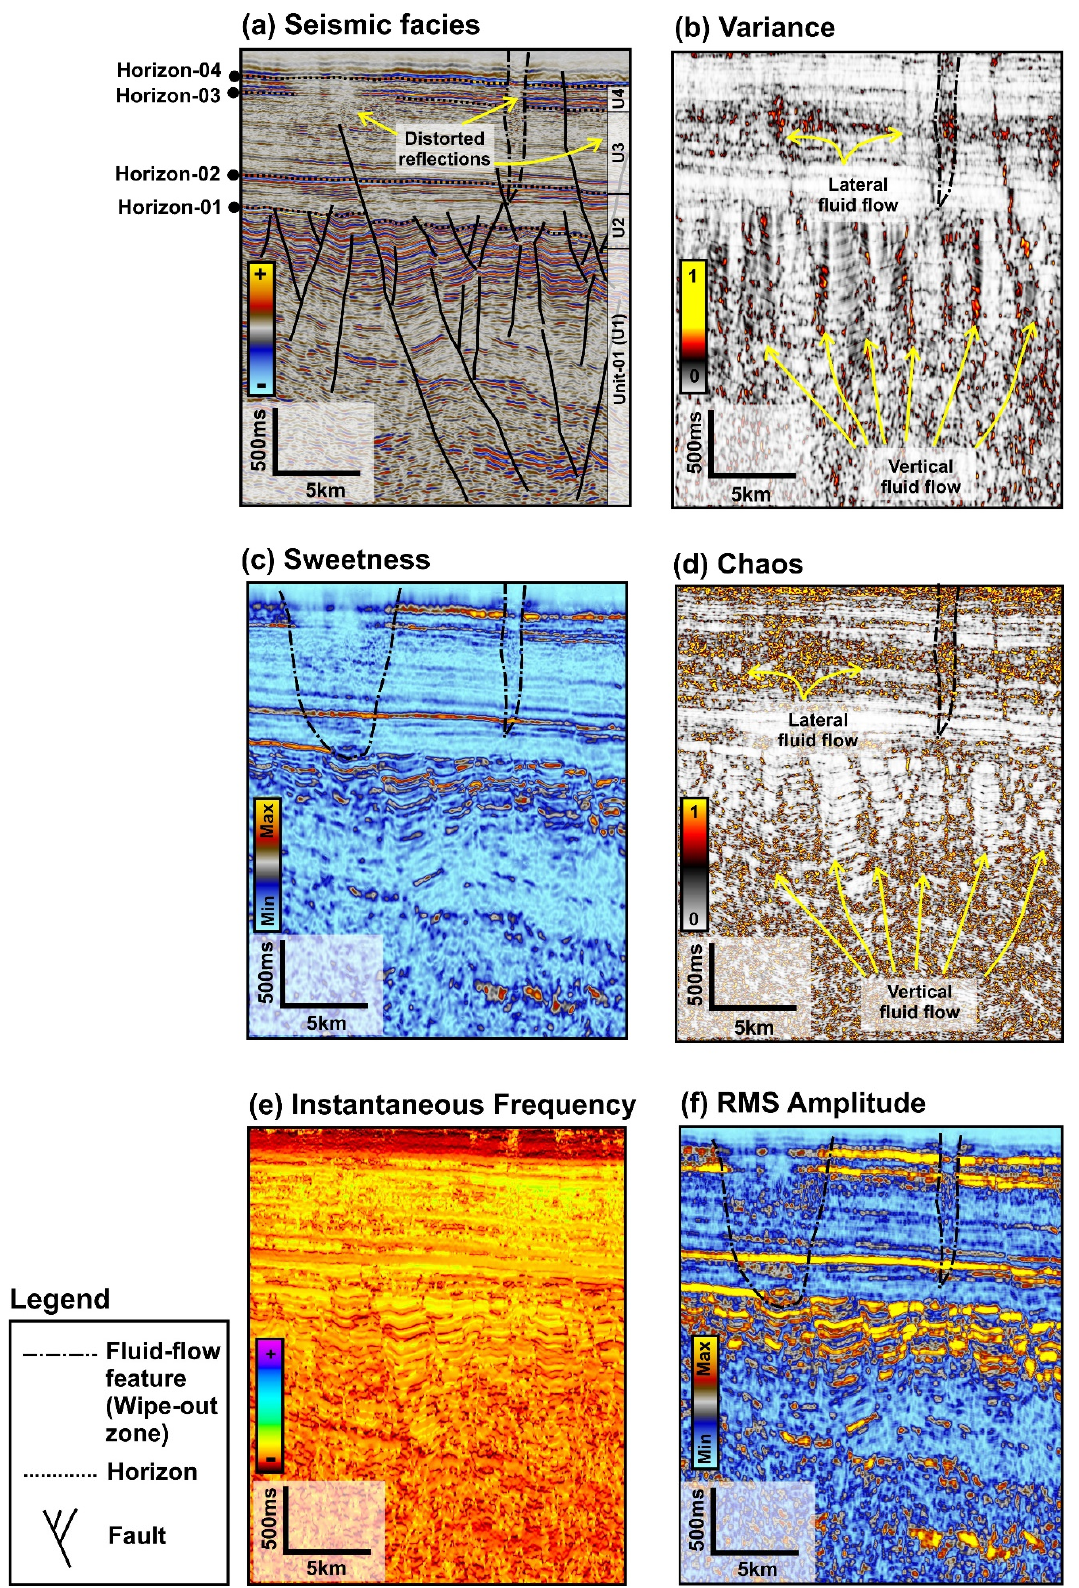
Figure 6. ( a ) Seismic facies and seismic attributes of line 5; ( b ) variance, ( c ) sweetness, ( d ) chaos, ( e ) instantaneous frequency, and ( f ) RMS amplitude, with fluid flow feature interpretation. See Figure 1a for section location.